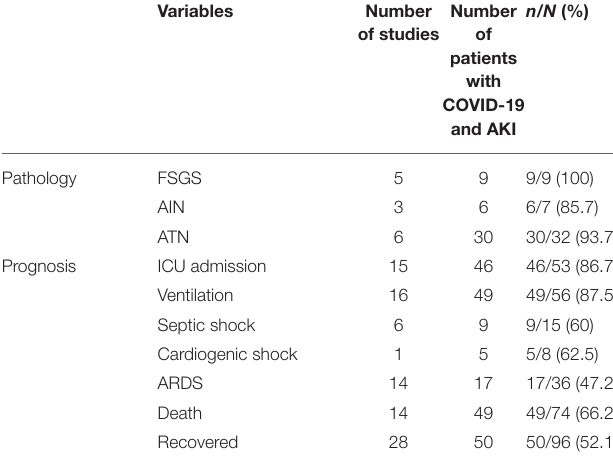
TABLE 2 | Stage of AKI in patients with COVID-19 base on KDIGO Clinical Practice Guideline definition.